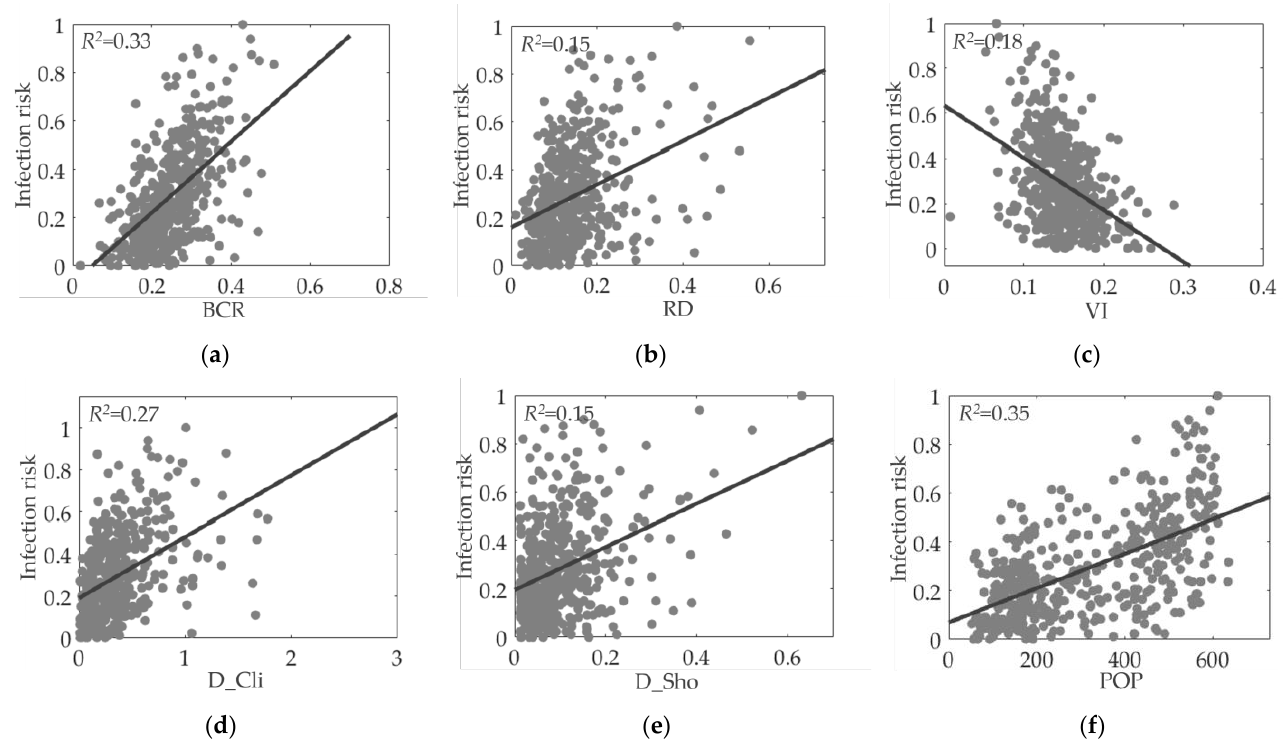
Figure 7. Impact of urban environment features on COVID-19 infection rate in Hong Kong: ( a ) Building coverage ratio; ( b ) Road density; ( c ) Vegetation index; ( d ) Density of clinics; ( e ) Density of shops; ( f ) Population.